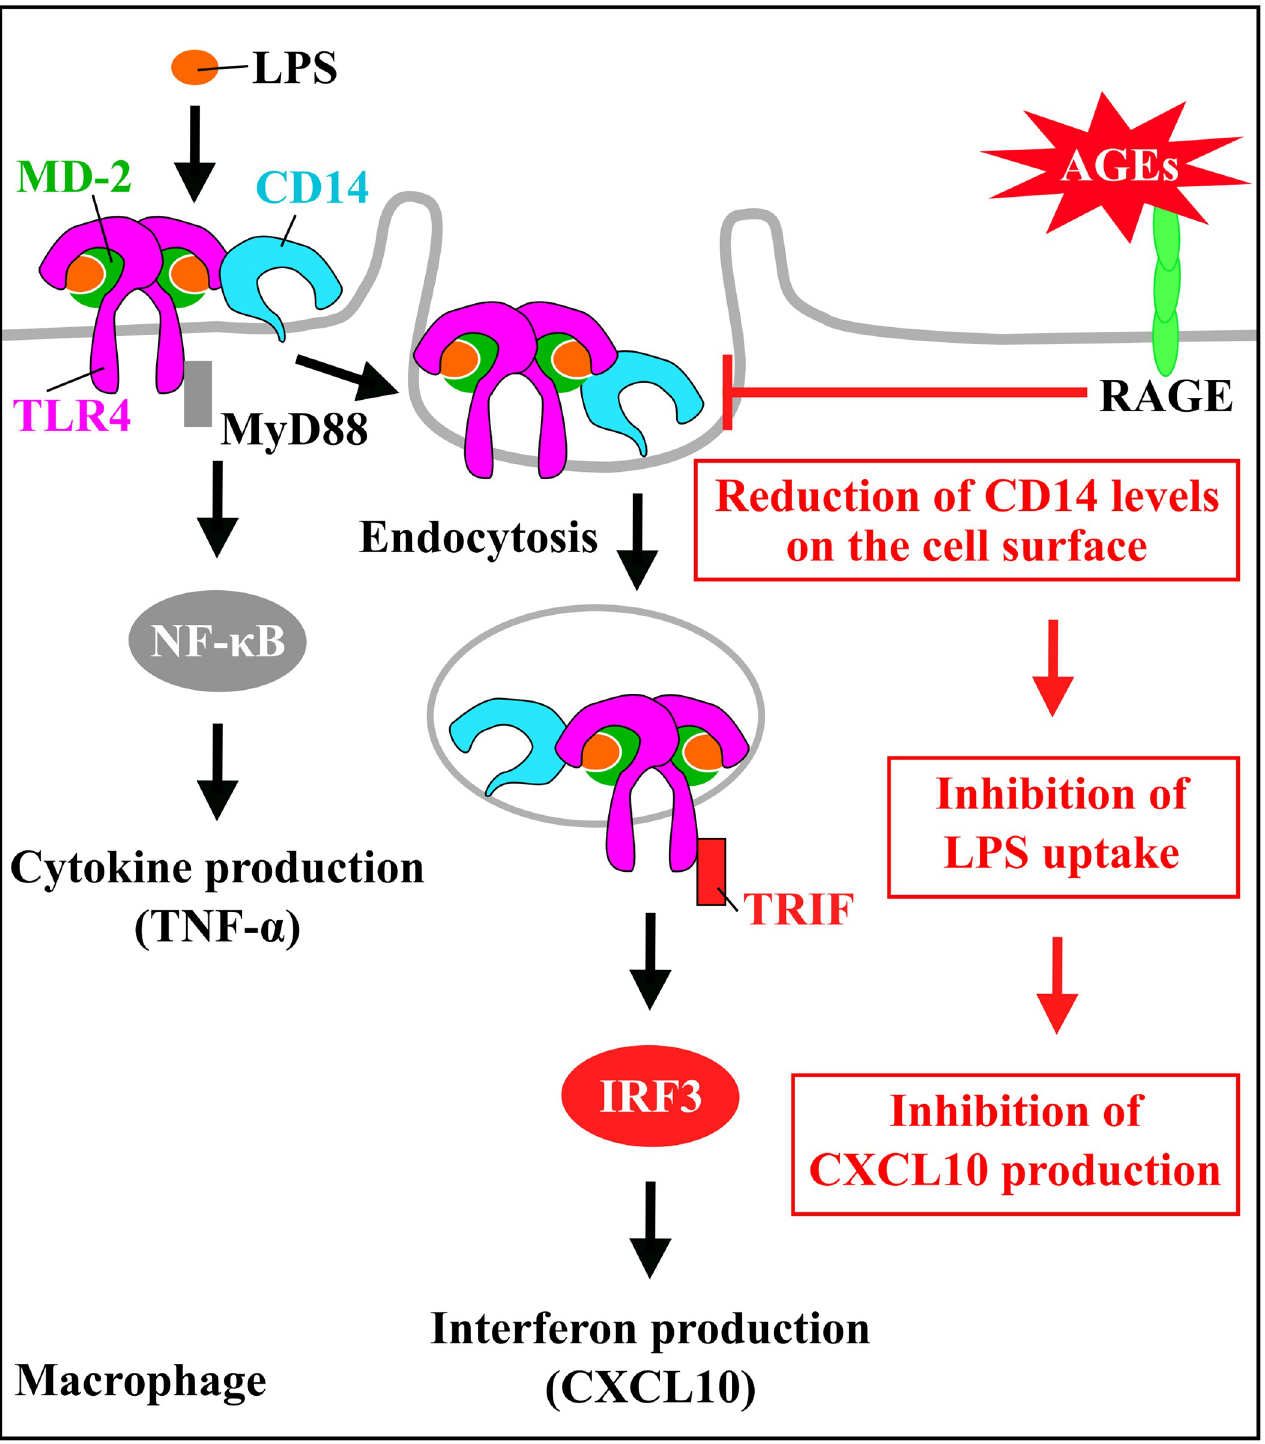
Fig 5. Model depicting the inhibitory effect of AGE-3 on the response to LPS in macrophages. LPS binding to CD14 is endocytosed via the formation of a dimerised TLR4/MD-2 complex. Subsequently, this assembly activates TRIF signalling on endosomes and the transcription of IFN-inducible genes including CXCL10. AGE-3 induces the downregulation of CD14 expression though RAGE. Downregulation of CD14 expression induced by AGE-3 contributes to the decreased LPS uptake and CXCL10 release in macrophages.